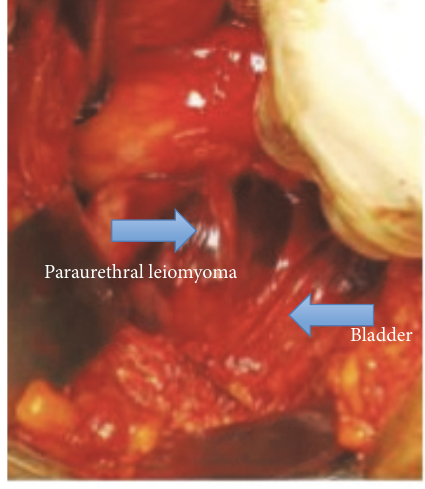
Figure 2: Intraoperative images of surgical